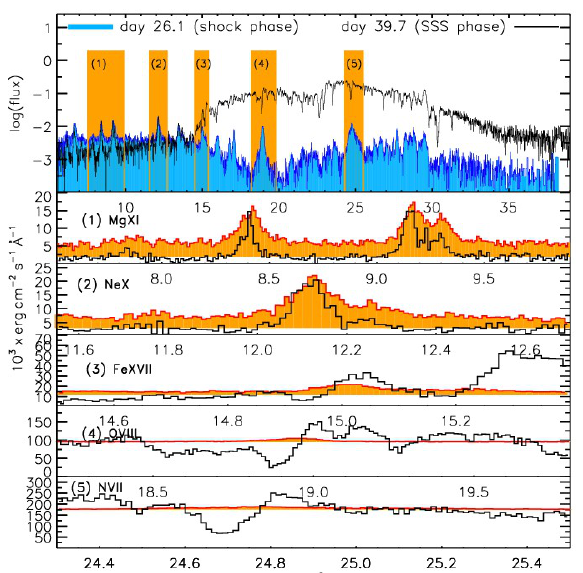
Figure 2: Comparison of a pre-SSS spectrum of RS Oph taken on day 26.1 and an SSS spectrum taken on day 39.7. In the top panel the entire wavelength range is shown in logarithmic units, illustrating that at short wavelengths, below ∼ 15 ˚A, the spectra are sim- ilar, only showing a decline the Bremsstrahlung con- tinuum component from day 26.1 to day 39.5. In the panels below, narrow wavelength regions are shown where the pre-SSS spectrum is added to the median of the day 39.7 spectrum in the same flux units. While short-wavelength lines have hardly changed, the excess emission lines on top of the SSS continuum are much stronger than before the start of the SSS